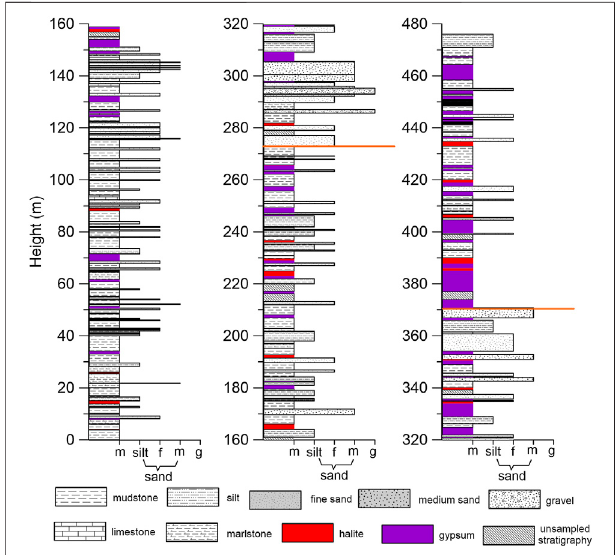
FIGURE2| StratigraphiccolumnoftheHuatugousectioninthewestern Qaidam Basin. The 476-m strata were subdivided into three units (Units 1 – 3) based on lithofacies associations and depositional